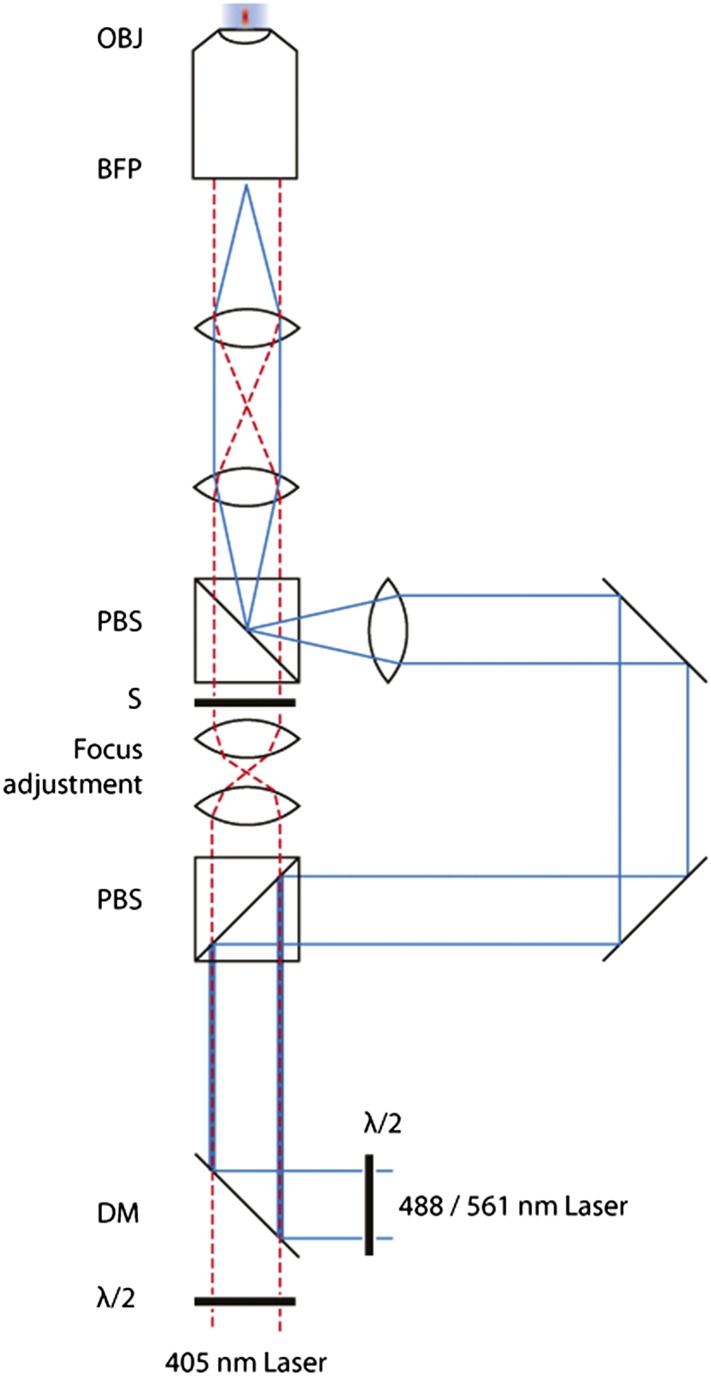
Schematic of the FRAP microscope.Lasers are combined and passed through a Polarizing Beam Splitter (PBS) whereupon the polarized light is split into two paths. By adjusting the half-wave plates, one can adjust the amount of light through either of the paths. A pair of identical plano-convex lenses (f1 = f2) allows the adjustment of the focus of the diffraction-limited spot along the optical axis. A shutter in this path controls temporal activation of the spot.